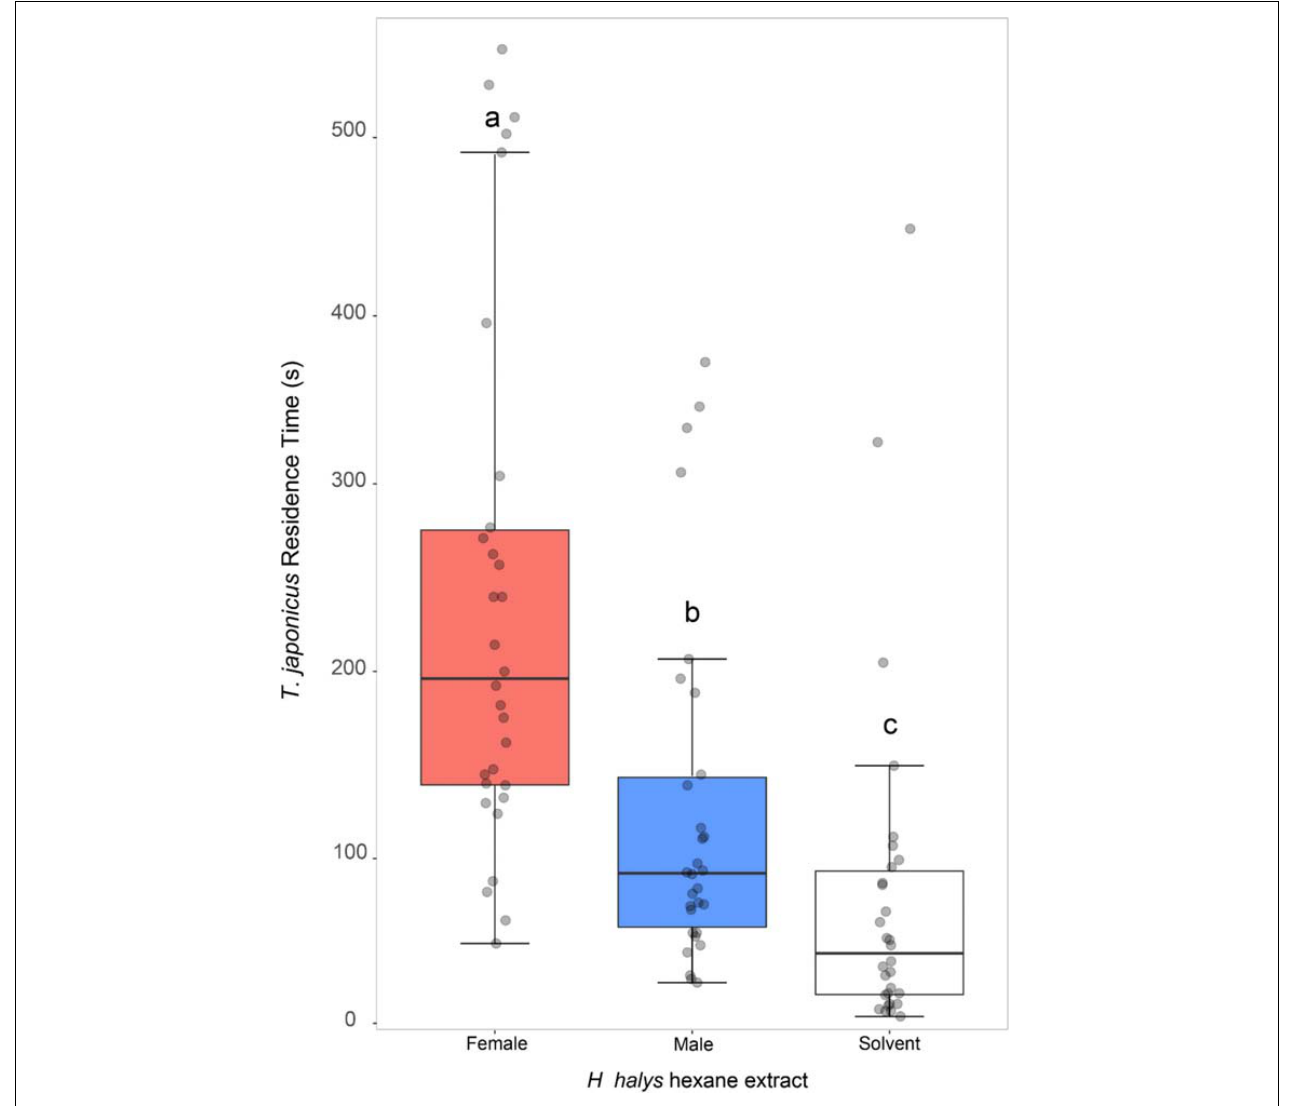
FIGURE 2 | Response of Trissolcus japonicus females to substrate treated with hexane extracts of Halyomorpha halys females (red box) or males (blue box) or with hexane only (white box). Bold horizontal lines show medians, boxes contain the 25 th –50 th percentiles, whiskers show the upper and lower quartiles and points represent individual replicates. Different letters indicate statistically significant difference ( P < 0.05,